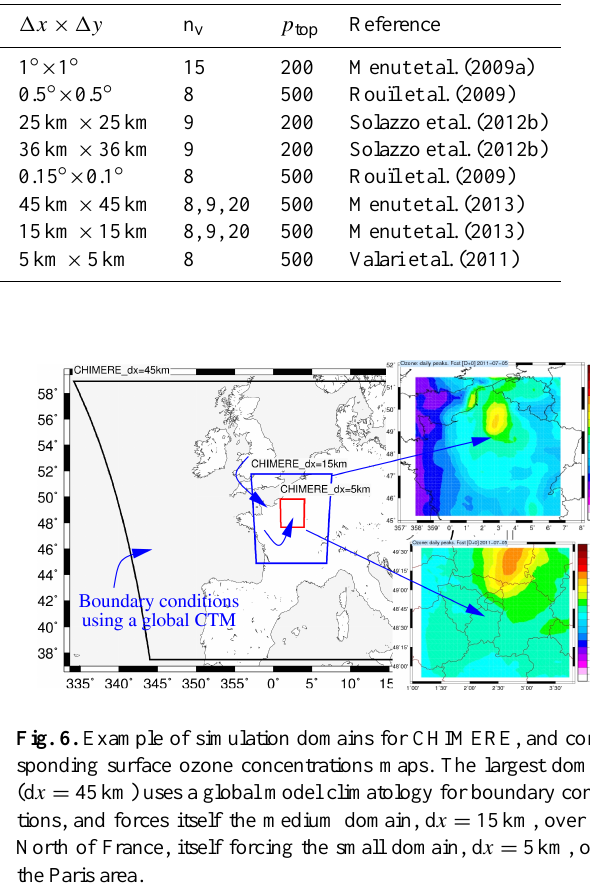
Menut L. et al. : CHIMERE: a model for regional atmospheric composition modelling 7 Domain description